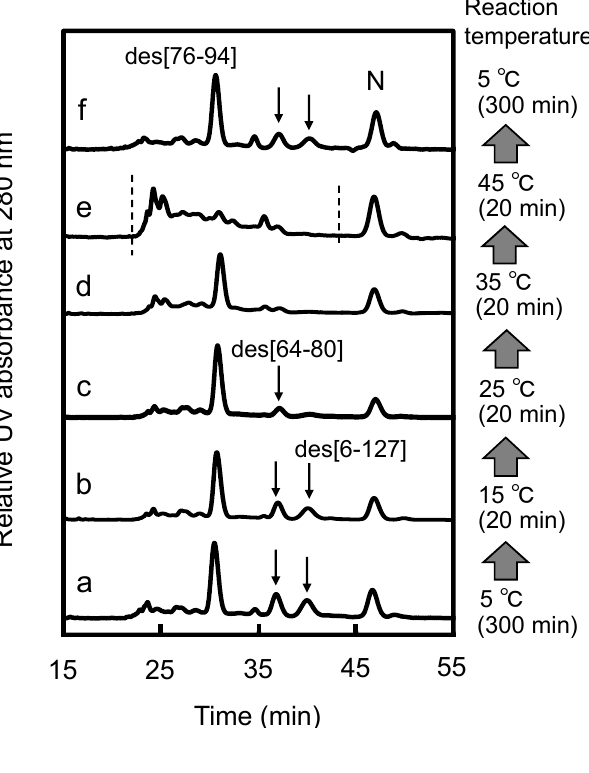
Figure 4. Reverse-phase HPLC chromatograms of the sample solutions (with AEMTS blocking) obtained from the temperature-jump experiment for the folding intermediates of HEL generated by the reaction of R with three equivalents of DHS ox at pH 8.0 in the presence of 2 M urea. Reaction conditions were [R] = [DHS ox ] /3 = 9.8 µM. ( a ) Incubated 0 0 at 5 °C for 300 min; ( b ) Incubated at 15 °C for 20 min after ( a ); ( c ) Incubated at 25 °C for 20 min after ( b ); ( d ) Incubated at 35 °C for 20 min after ( c ); ( e ) Incubated at 45 °C for 20 min after ( d ); ( f ) Incubated at 5 °C for 300 min after ( e ). See the text for details of the HPLC analysis